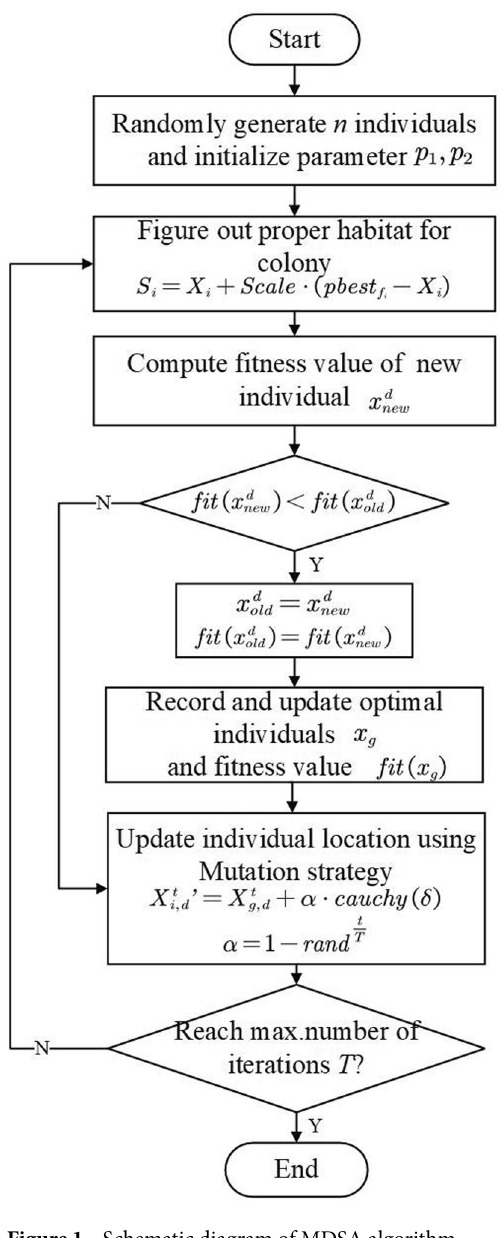
Figure 1. Schematic diagram of MDSA